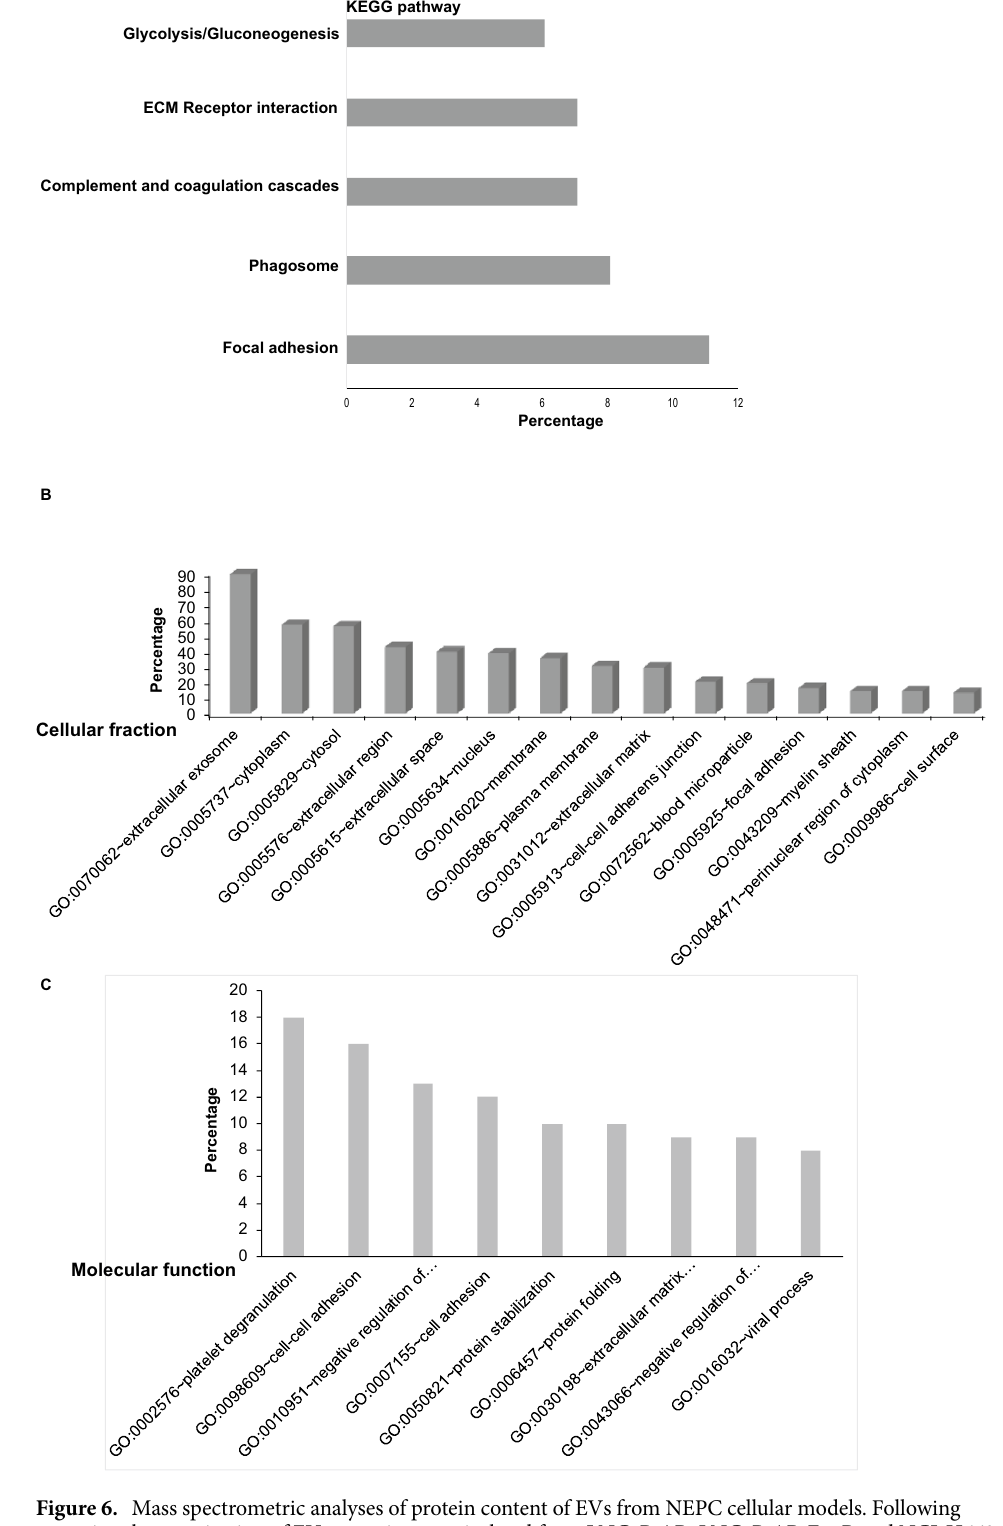
Figure 6. Mass spectrometric analyses of protein content of EVs from NEPC cellular models. Following extensive characterization of EVs, proteins were isolated from LNCaP-AR, LNCaP-AR-EnzR and NCI-H660 cells followed by mass spectrometric analyses by Shot gun approach and analyses by (DAVID) v 6.8 software 63 to discover the association of identified proteins with biological processes, cellular components and KEGG pathways 36,37 . ( A ) KEGG pathways 36,37 impacted by proteins isolated from EVs of NCI-H660 cells as compared to EVs from LNCaP-AR cells. ( B ) Cellular fraction of EV proteins from NCI-H660 cells as compared to EVs from LNCaP-AR cells. ( C ) Molecular function of EV proteins from NCI-H660 cells as compared to EVs from LNCaP-AR